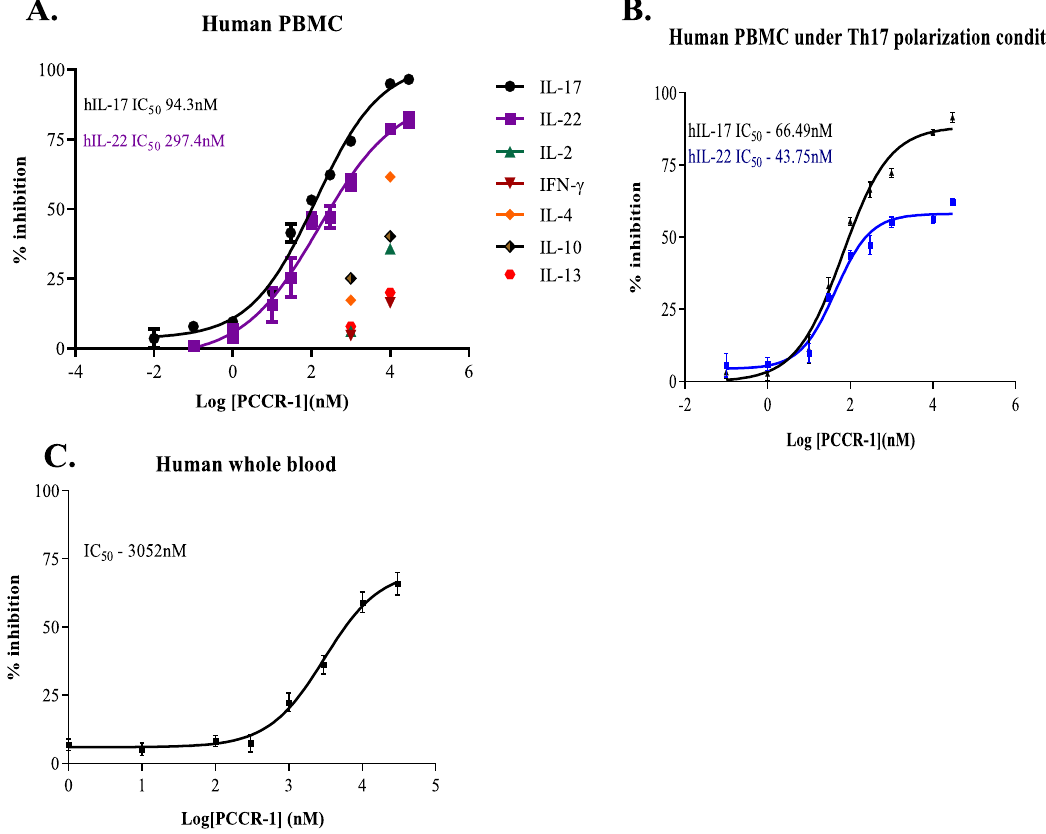
Figure 3. PCCR-1 strongly binds with RORγ across species under Th17 polarization condition and also modulate in whole blood. Th17 dependent regulation of PCCR-1: Dose dependent inhibition of ( A ) Th1, Th2, Th17 cytokine production from human PBMC, ( B ) Th17 cytokine production from human PBMC under Th17 polarization conditions (n = 2), the basal value was negligible and on stimulation the IL-17 level was in the range of 1100-1500 pg/ml across donors and 17-45 pg/ml in basal and on stimulation the IL-22 was in the range of 500-835 pg/ml ( C ) IL-17 cytokine from human whole blood (n = 10) with negligible basal and IL-17 in the range of 267—1532 pg/ml. ‘n’ is a representative data from two to three donors in